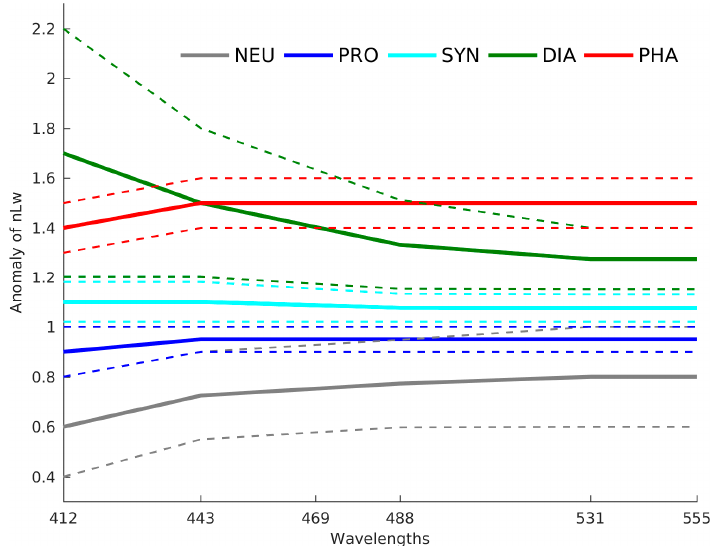
Figure 4. The acceptable PHYSAT ranges of the nLw anomalies (dashed lines) for each phytoplankton functional type (PFT) [24]. The continuous bold lines represent the mean values for each group. Abbreviations: COB: Coccolithophorids bloom; PHA: Phaeocystis -like; DIA: Diatoms; SLC: Synechococcus ; PRO: Prochlorococcus ; and NEU: Nanoeukaryotes.